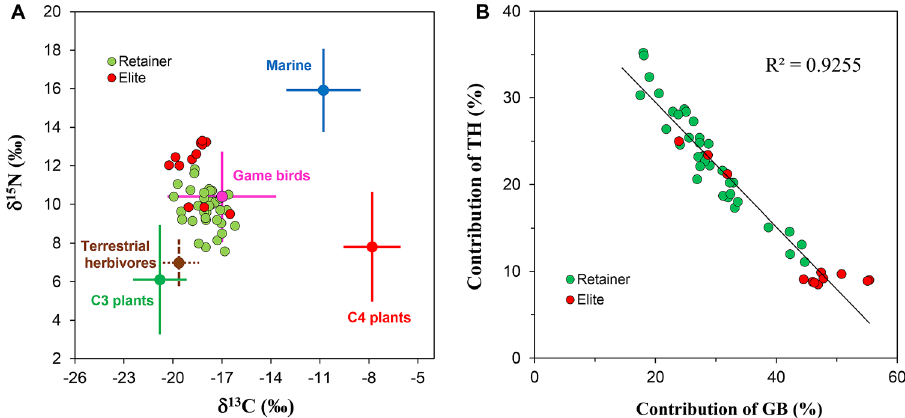
Figure 4. Isotopic plot of humans from the Imdang tombs in relation to the potential five food sources generated by the MixSIAR model ( A ) and the relationship between the percent contributions of the game birds (GB) and terrestrial herbivores (TH) to each human ( B ). The previously published isotopic values of humans (n = 18) from Joyeung C 56 are added and calculated using the MixSIAR model. Isotopic values of the five food sources were adjusted for trophic discrimination factors (C 3 plant: Δ 13 C = 5.2‰ and Δ 15 N = 3.8‰; C 4 plant: Δ 13 C = 4.5‰ and Δ 15 N = 3.8‰; animal: Δ 13 C = 1‰ and Δ 15 N = 3.8‰) 33,34,69 . In terms of contributions for each food to the human diet, there was a negative correlation between game birds and terrestrial herbivores (r = − 0.962, P < 0.0001).